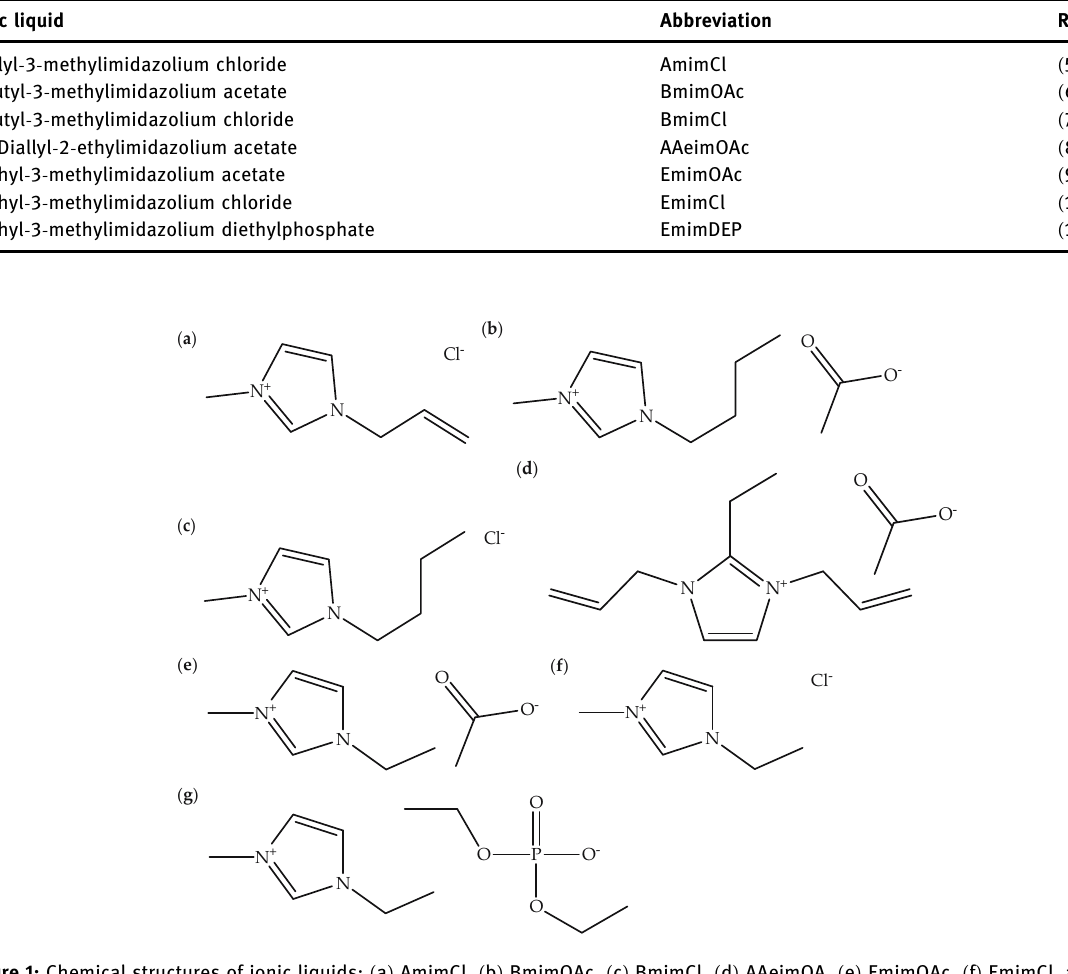
Figure 1: Chemical structures of ionic liquids: ( a ) AmimCl, ( b ) BmimOAc, ( c ) BmimCl, ( d ) AAeimOA, ( e ) EmimOAc, ( f ) EmimCl, and ( g ) EmimDEP.